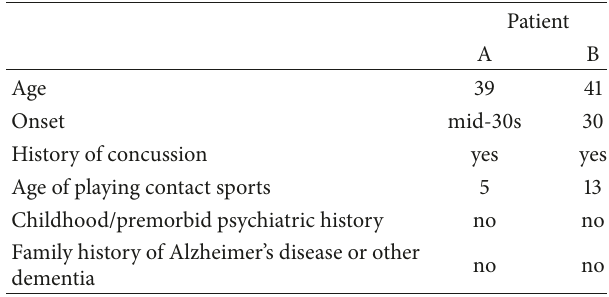
Table 1: Patient clinical information. Patient clinical information is